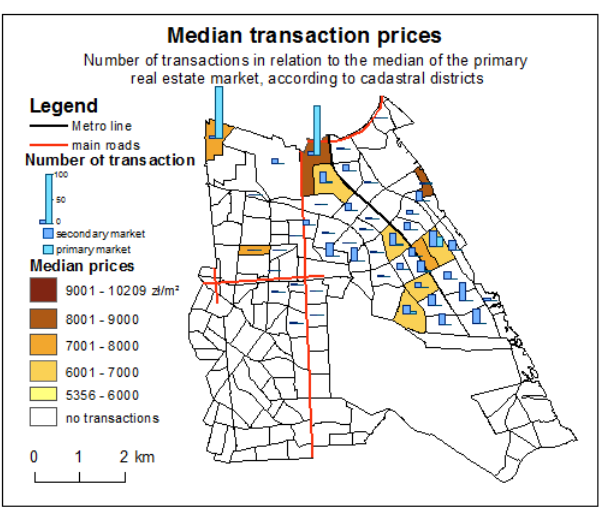
Fig. 10. Number of transactions on the primary and secondary residential real estate markets in Ursynów in relation to the median of the primary real estate market, according to cadastral